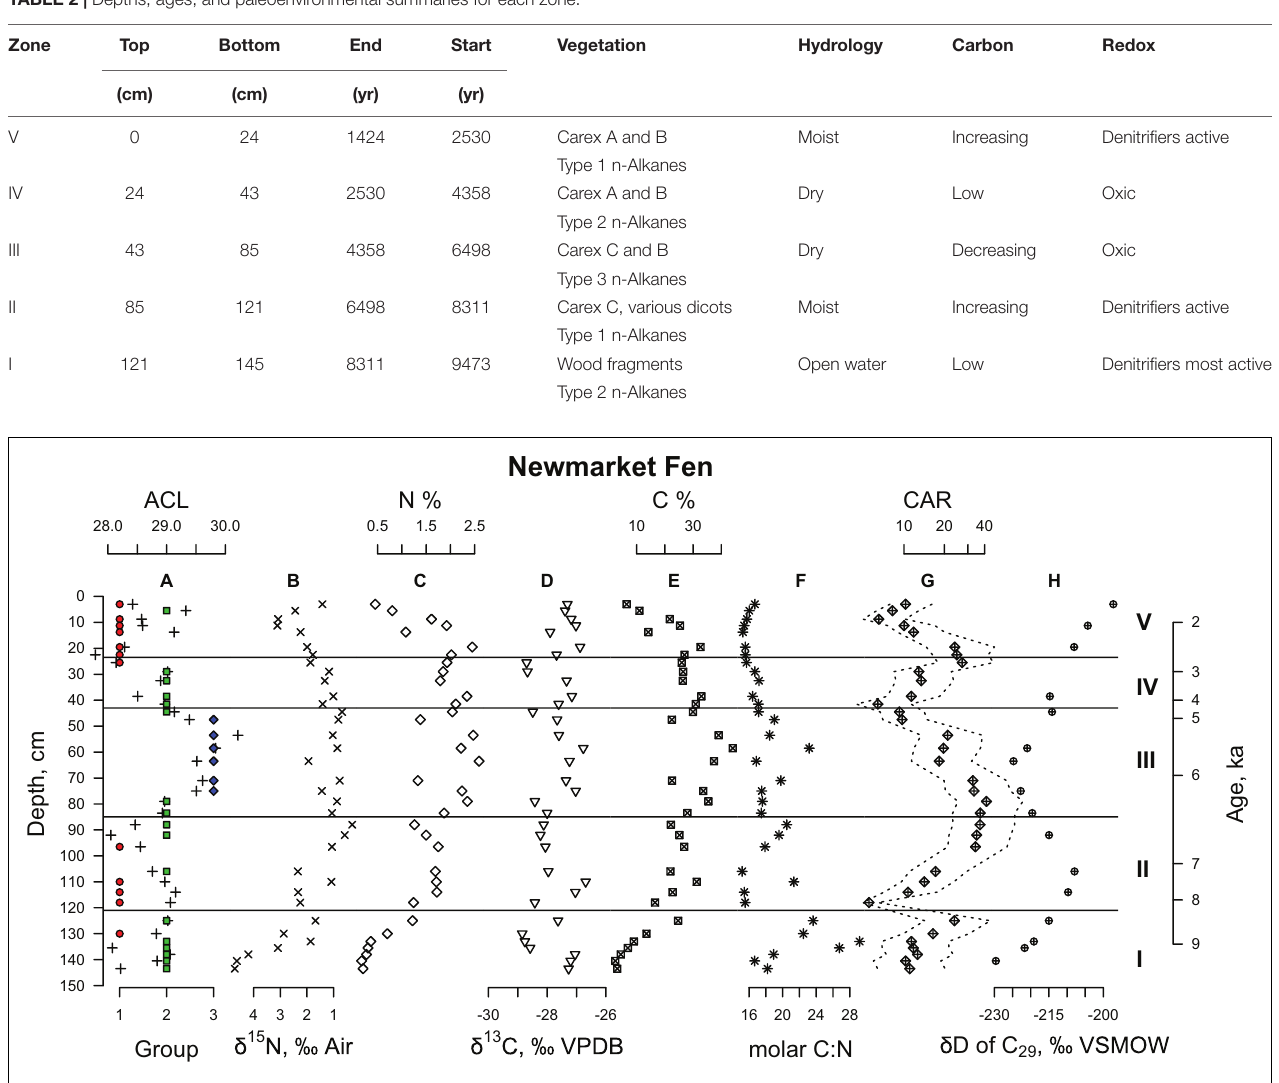
TABLE 2 | Depths, ages, and paleoenvironmental summaries for each zone.